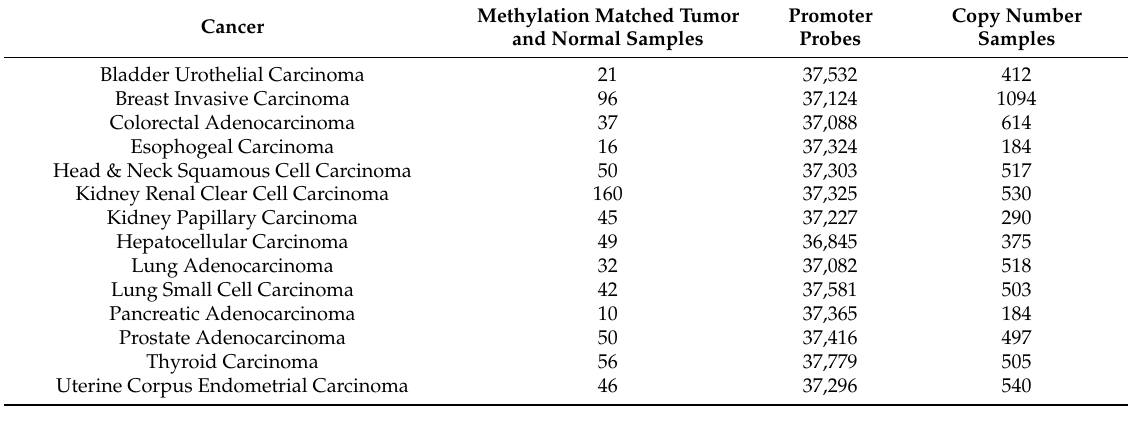
Table 1. Methylation and copy number alteration datasets used in this work.